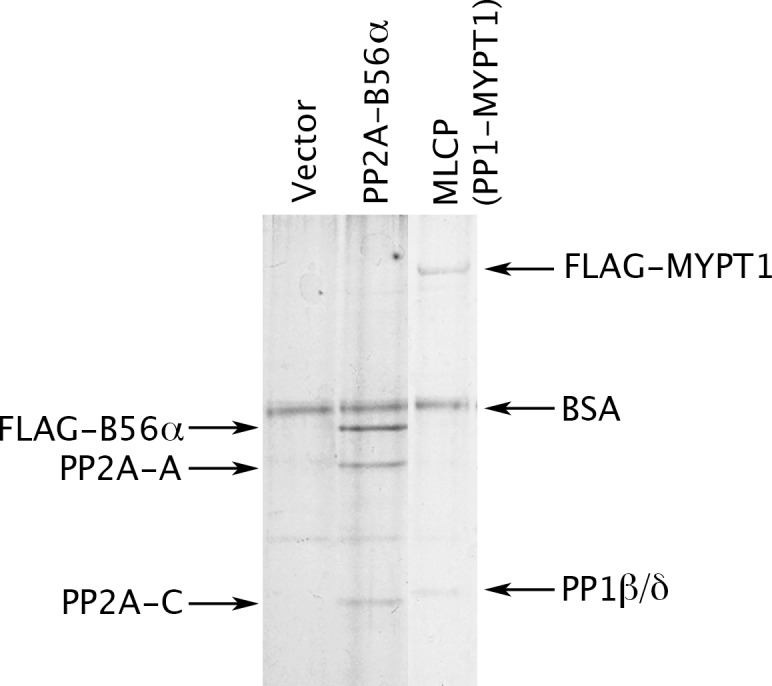
Preparation of MLCP.HEK-293 CRL-1573 cells were transformed with empty vector, with a construct overexpressing a FLAG-tagged version of the B56α regulatory subunit of PP2A for comparison, or with a construct overexpressing FLAG-MYPT1. Phosphatase holoenzymes were then purified as previously described (Adams and Wadzinski, 2007; Williams et al., 2014) and stabilized by the addition of bovine serum albumin (BSA). The myosin phosphatase holoenzyme in the third lane has both FLAG-MYPT1 and PP1β/δ in roughly equal stoichiometry; the identity of these proteins was verified by Western blotting with anti-FLAG and with antibodies specifically directed against the α, β/δ, and γ isoforms of the PP1 catalytic subunit (data not shown).